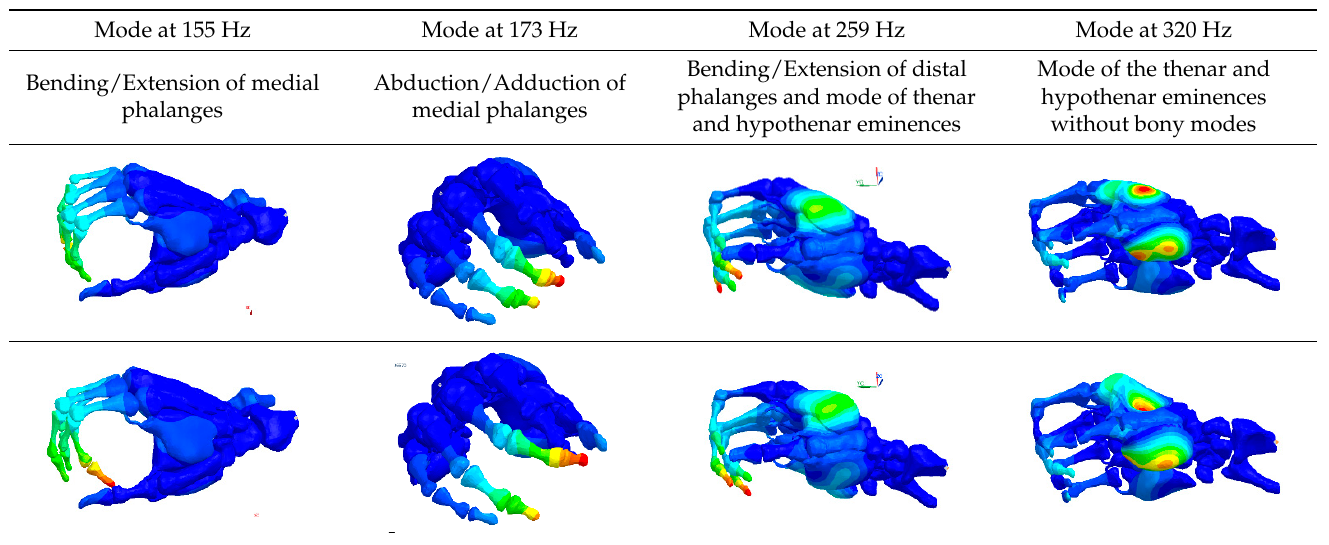
21 Table A1. Eigenfrequencies and eigenmodes of the hand. Mode at 28 Hz